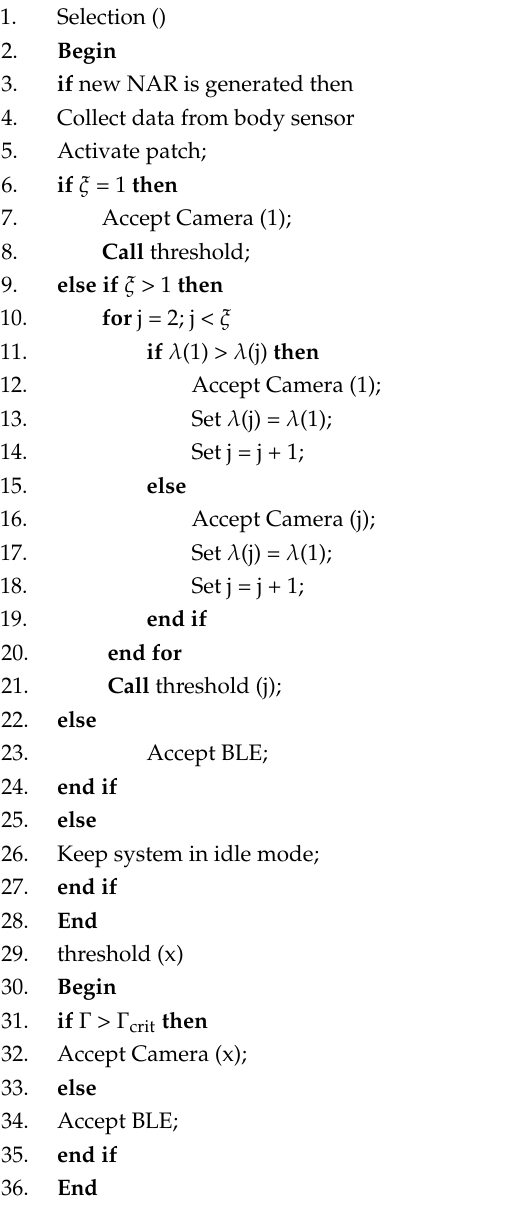
Algorithm 2: Access point selection for new